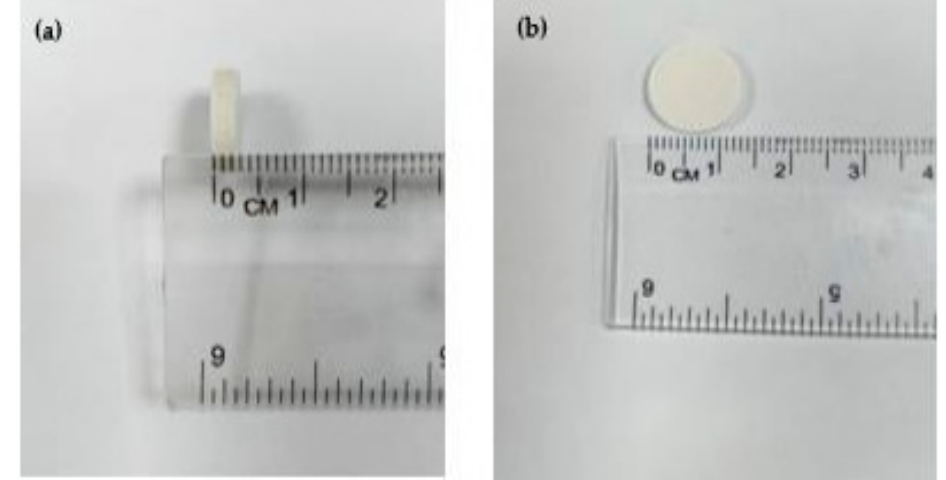
Figure 1. Fabricated scaffolds’ ( a ) side view and ( b ) top view.